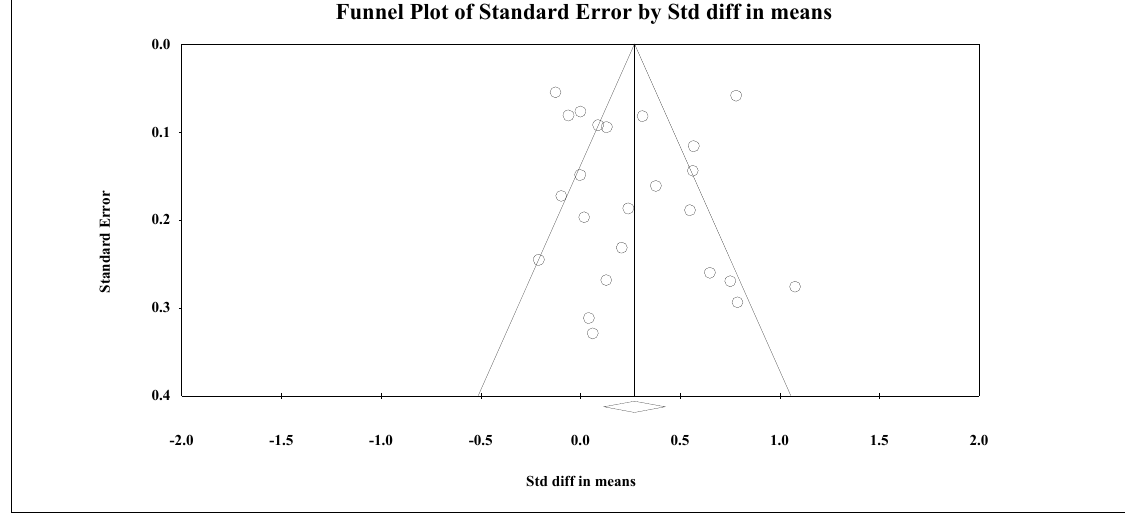
Figure 5. Publication bias in reporting of serum HbA1c levels outcome. Table 1. Subgroup analyses for biomedical outcomes ( n =